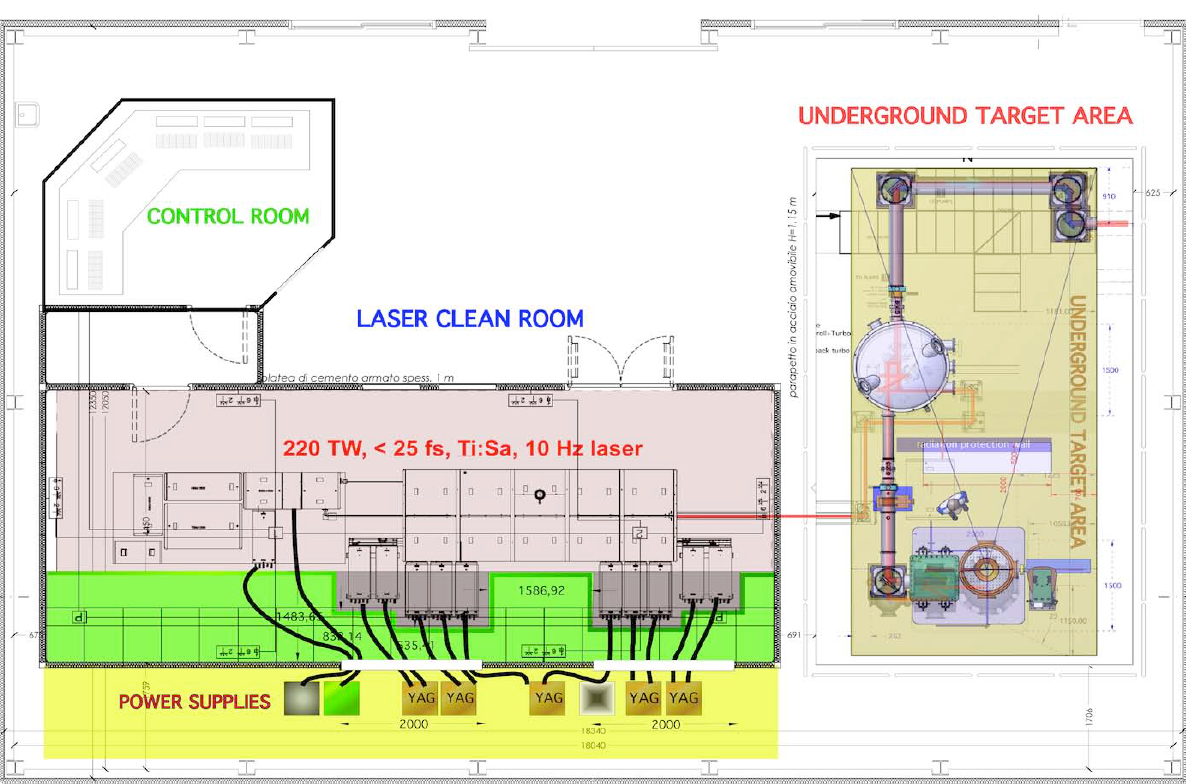
Figure 7. General layout of the FLAME installation showing the entire laser chain inside the clean room, the underground target area and the control room. The laser includes the front-end on the left up to the cryogenic amplifier on the right, with its 10 Nd:YAG pump lasers. The underground target area shows the set-up for the self-injection test experiment at FLAME with the main hardware components including the 90 deg turning mirror, the off-axis parabola assembly and the interaction chamber. Also visible on the r.h.s. is the electron spectrometer consisting of a dipole magnet and the